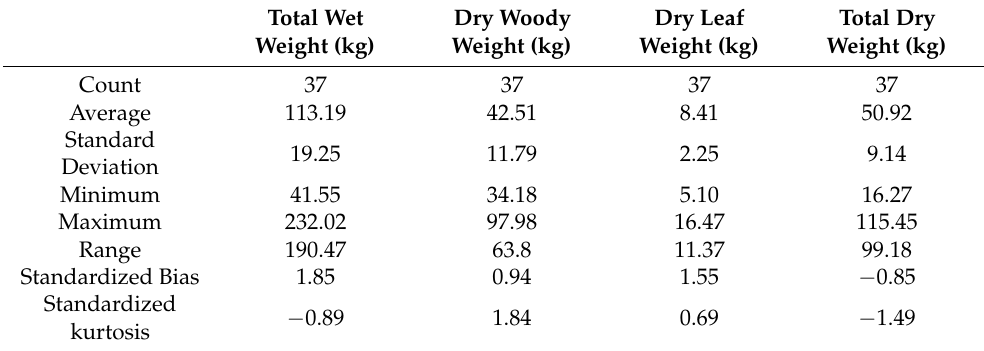
Table 3. Statistical description of woody and foliar biomass weighted wet and